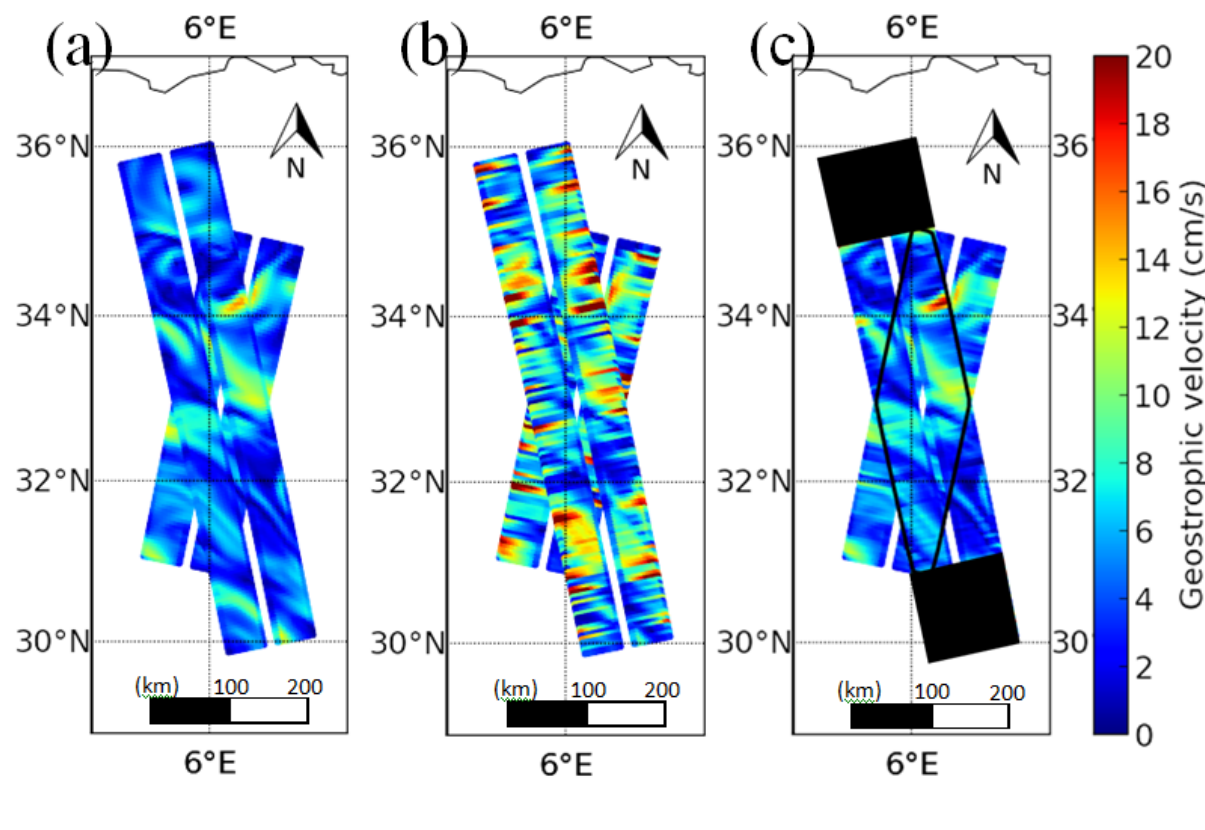
Figure 15. Example of calibration with the crossover method. Geostrophic velocity field from the high-resolution model of Klein et al. [8]: error-free measurements ( a ), with uncalibrated roll ( b ), and after crossover calibration ( c